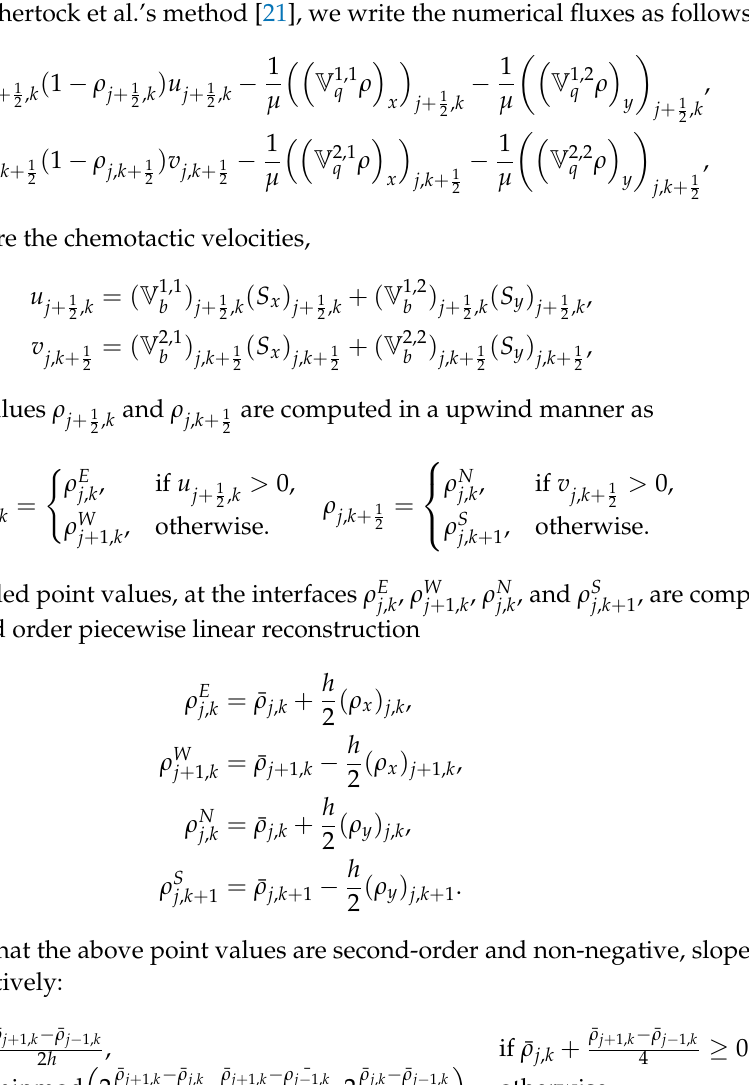
Figure 1. Stencil for the numerical flux for F tives in the upwind directions, and the blue lines represent the derivatives in the perpendicular directions. Note that the upwind direction can be any of N, S, E, W, and, here, we only show the N and E